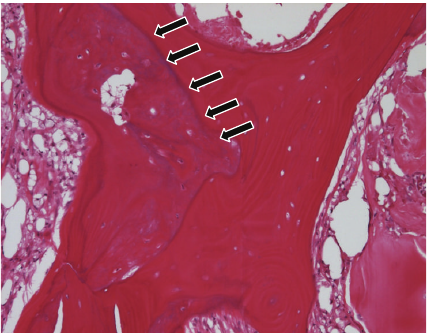
Figure 4: Microscopic findings in high magnification field ( × 100, HE stain). New bone formation is observed adjacent to necrotic trabecular bone characterized to empty lacuna (black